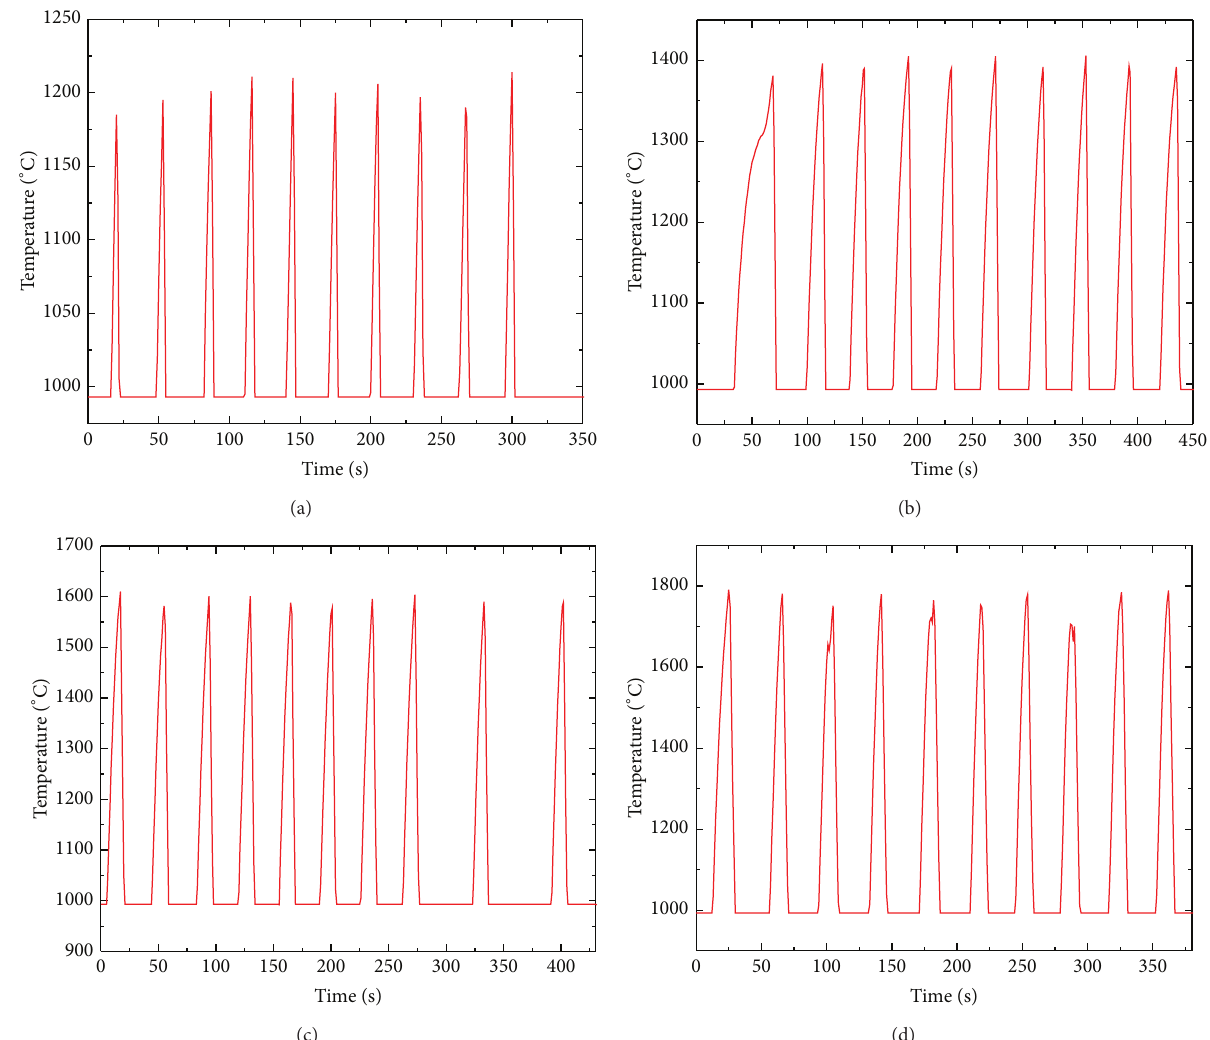
Figure 3: Temperature curve of thermal shock 10 times: (a) 1200 ∘ C; (b) 1400 ∘ C; (c) 1600 ∘ C; (d) 1800 ∘